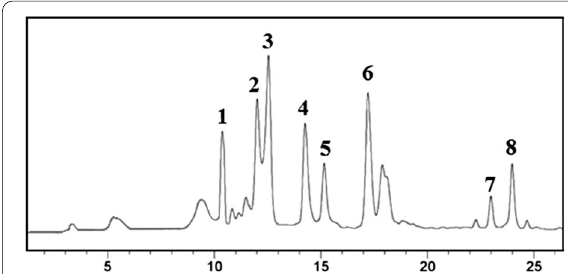
Fig. 3 HPLC of silymarin constituents of the Silybum marianum ethanolic extract